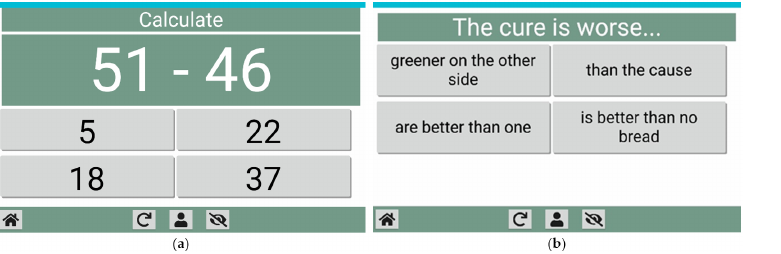
Figure 5. Examples of the “addition and subtraction” calculation game ( a ) and the “sayings” language game ( b